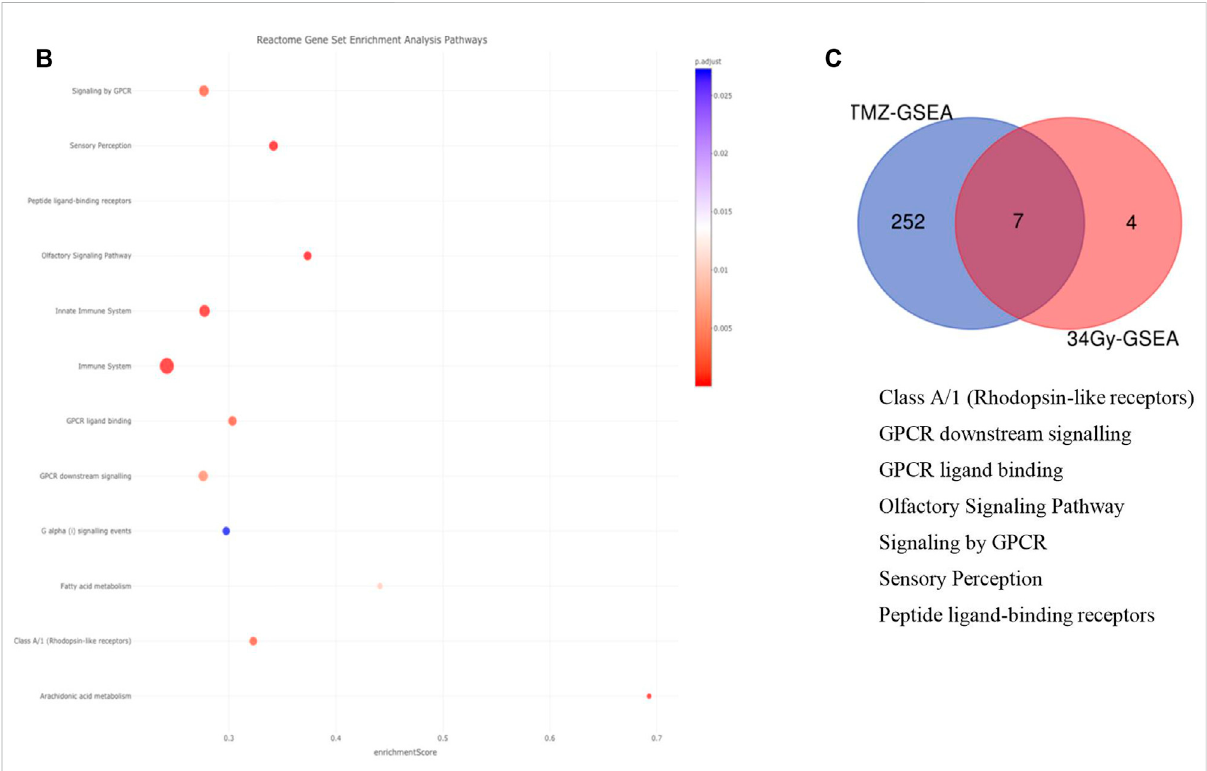
FIGURE 4 ResultsofthepathwayenrichmentanalysisforDMGsfrom (A) TMZ,m-MGMT(top50pathways)and (B) 34Gy,m-MGMT.Thenumberofunique and shared enriched pathways between the two groups (C) (TMZ-blue and 34Gy-red) is presented as a Venn diagram. The shared pathways are also